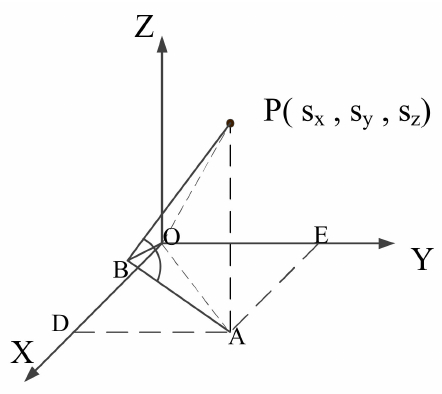
Figure 7. Schematic diagram of the fourth degree of freedom calculation